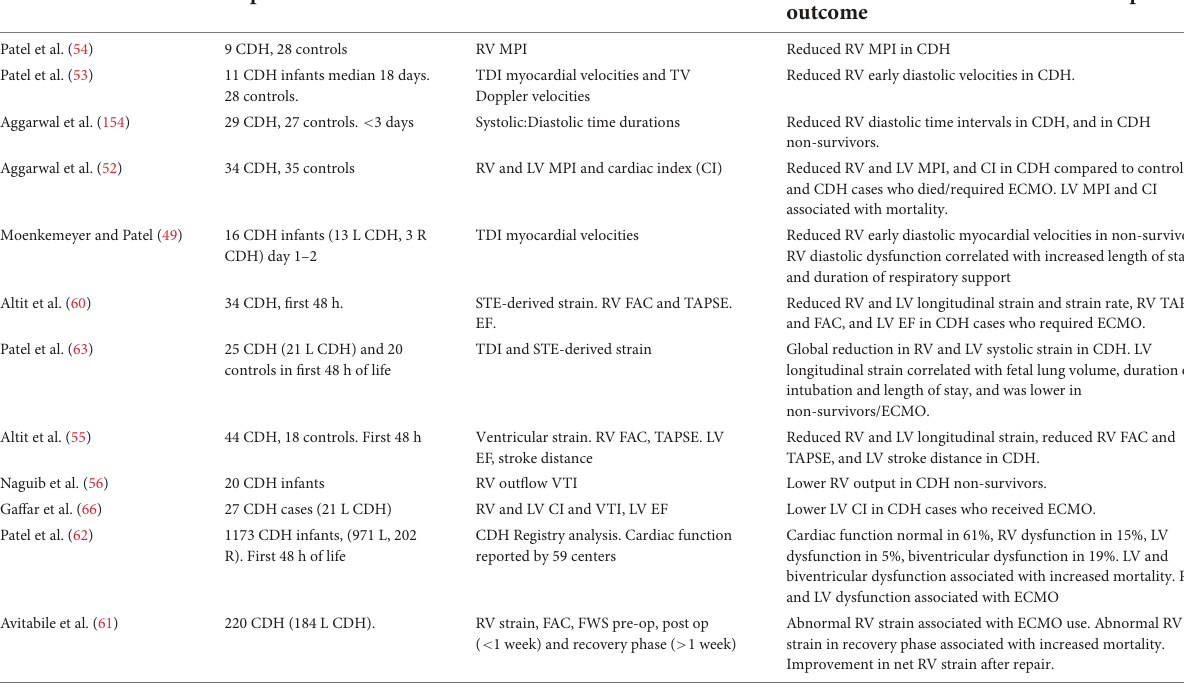
TABLE 3 Early postnatal cardiac function in